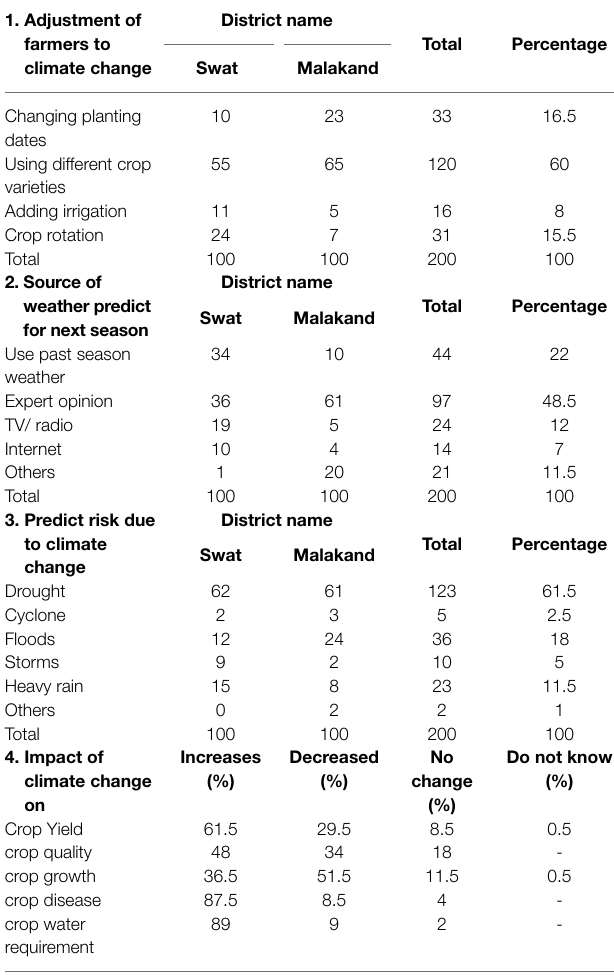
TABLE 2 | Countermeasures to climate changes adopted by farmers. 1. Adjustment of farmers